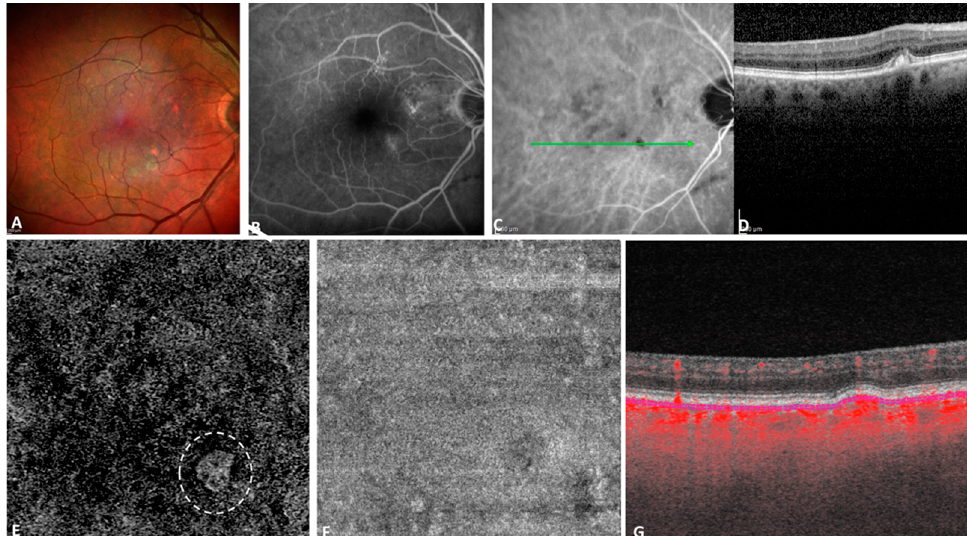
Figure 3. Multimodal imaging of an 86 years old patient with a small subclinical macular non-exudative neovascularization on the study eye. Multicolor imaging revealing soft drusen ( A ) that appeared hyperfluorescent on fluorescein angiography (FA) ( B ) and hypofluorescent on the late indocyanine green angiography (ICGA) frame. ( D ) Spectral domain optical coherence tomography (SD-OCT) revealed a small hyperreflective drusen, corresponding to a hypofluorescent area on ICGA ( C ). The manual 10 µ m thick segmentation located 31 µ m posterior to the RPE fit reference with projection artifact removal ( E ), revealed the presence of a small high flow neovascular network (dashed white circle) with the en face structural slab ( F ). The corresponding B-scan with flow overlay ( G ) confirmed the presence of flow within the drusen.